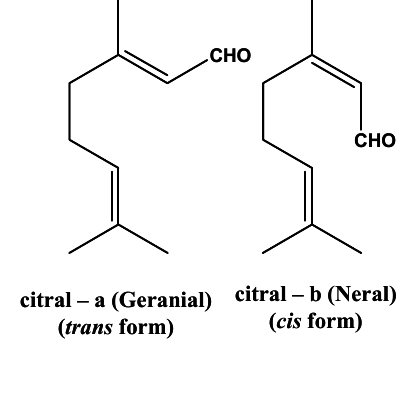
Figure 1. Structure of citral geometric